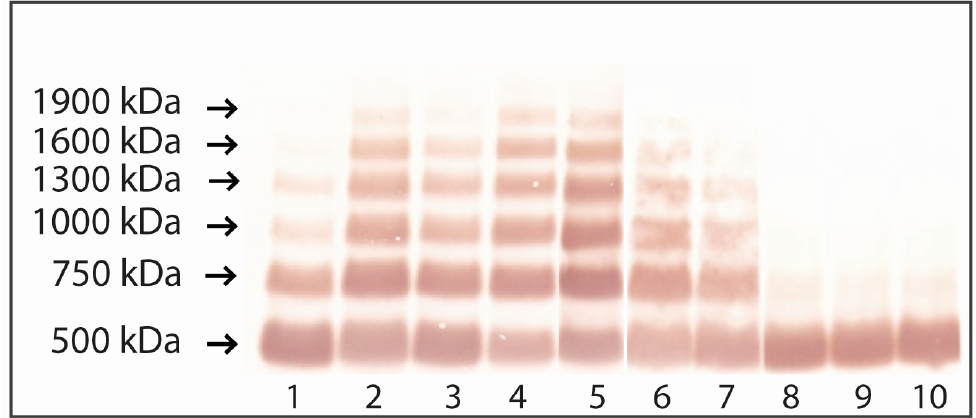
Figure 3. Representative immunopatterns of FN-fibrin complexes in blood plasma of women with endometriosis, fertility disorders and in the normal group. The 66 blood plasma samples of women with endometriosis and fertility disorders and 25 plasma samples from healthy individuals were subjected to SDS-agarose immunoblotting under non-reducing conditions [50,55]. Samples: Lanes 1–4 plasma of women with endometriosis; lanes 5–7 plasma of women with fertility disorders; lanes 8–10 plasma of women from control group. The molecular masses of plasma FN-fibrin complexes of 750 to 1900 kDa and 500 kDa FN dimer are shown by arrows on the